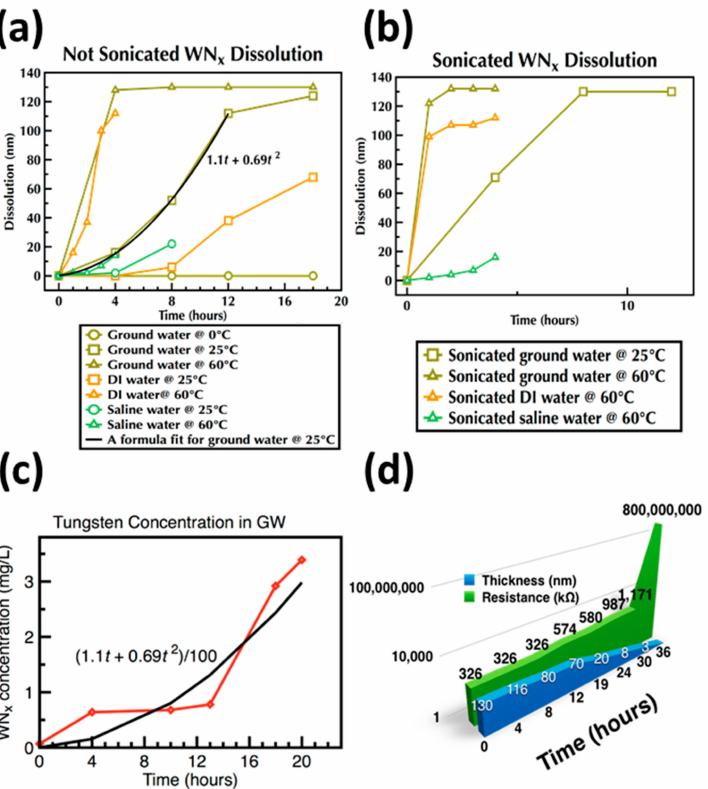
Figure 4. Dissolution rate of amorphous WN x in different solutions. ( a ) Dissolution without sonica- tion and ( b ) dissolution with sonication; ( c ) tungsten concentration in ground water (GW) solution at RT; ( d ) relationship between reduction in device thickness over time and